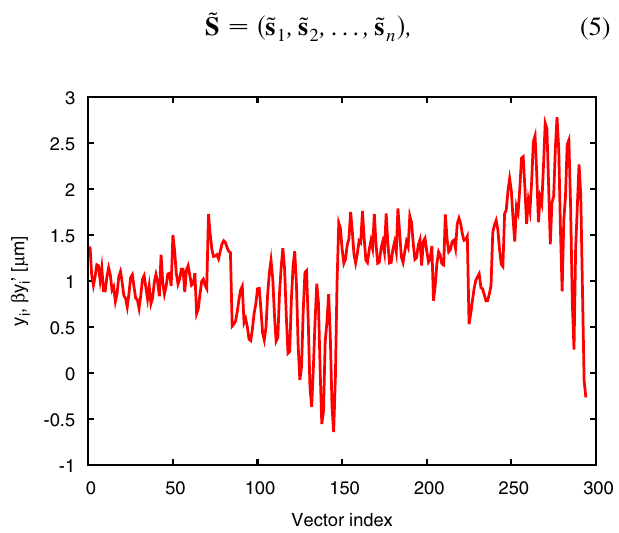
FIG. 6. Typical seed vector for a beam consisting of 147 macroparticles. Vector indices 1–147 represent macroparticle and indices 148–294 represent scaled macroparticle positions y i . For positions and angles, respectively, indices are angles (cid:5) y 0 i ordered according to longitudinal position.